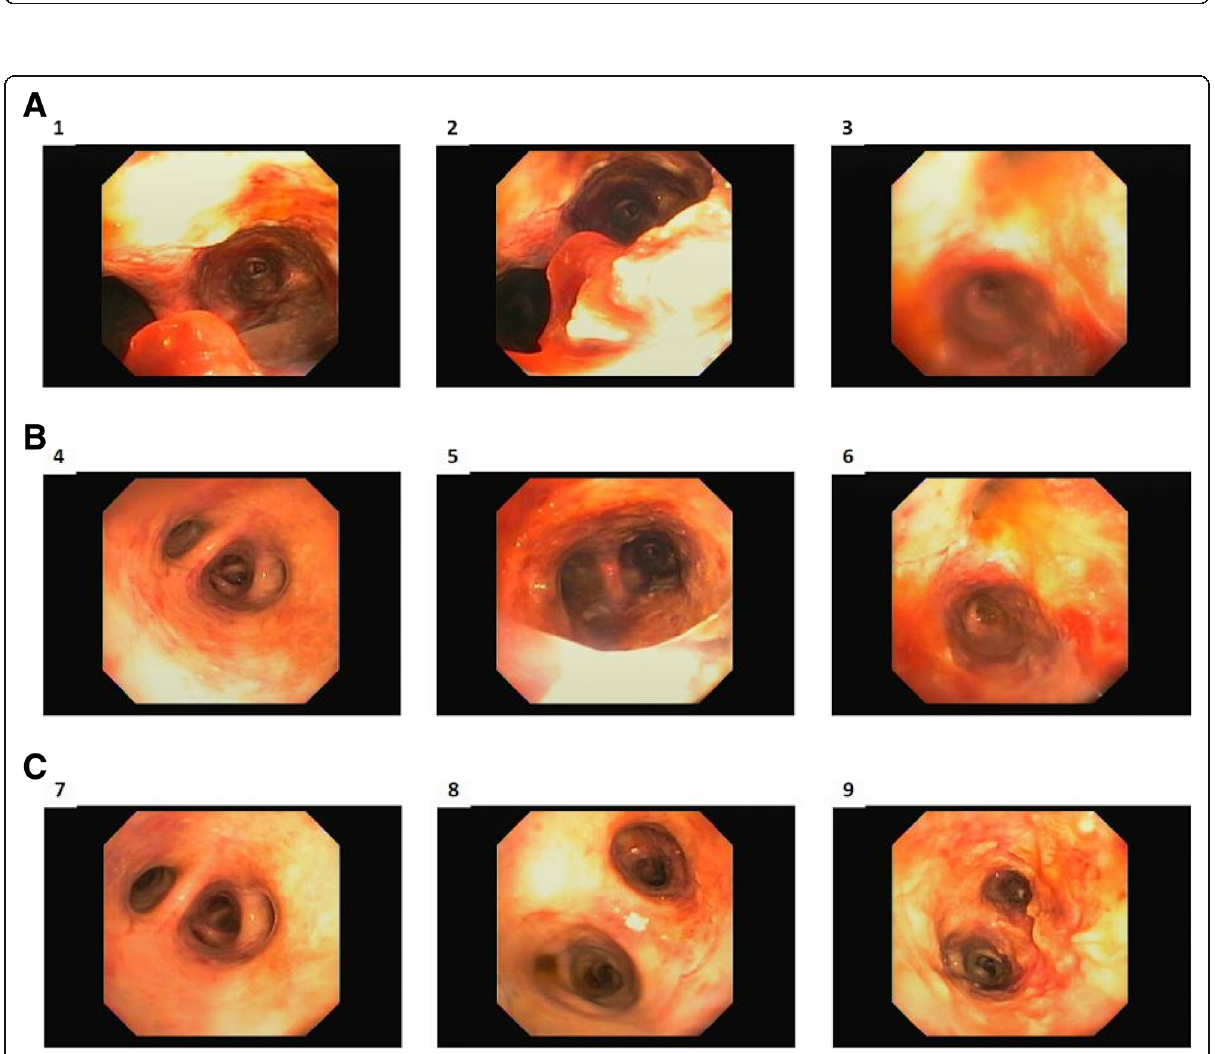
Fig. 2 Bronchoscopy on admission provided evaluation of the tracheobronchial tree. Sequential images from proximal to distal show diffusely edematous, denuded main airways indicative of inhalational injury. The very distal subsegments were